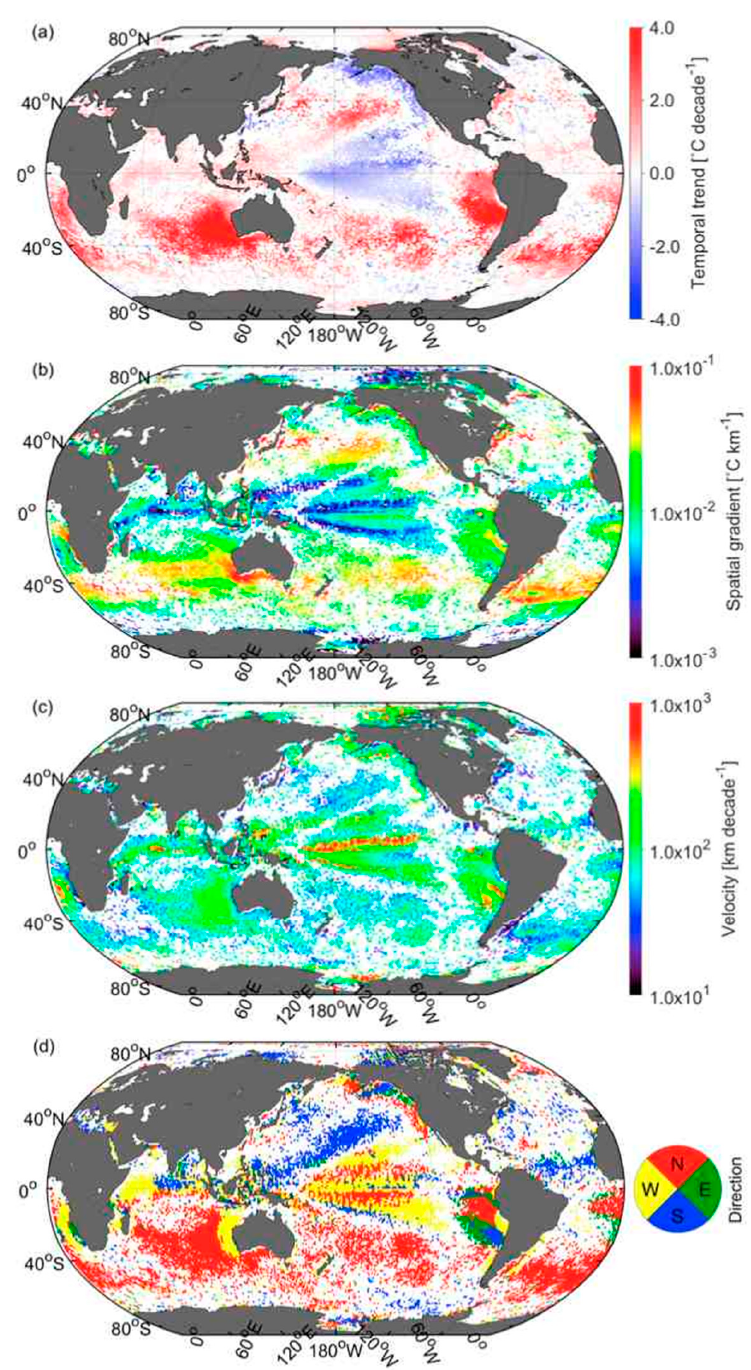
Figure 10. Global distribution of: ( a ) temporal trend; ( b ) spatial gradient; ( c ) velocity; and ( d ) direction of SST. White shows the area with non-significant ( p > 0.05) temporal trend for the period